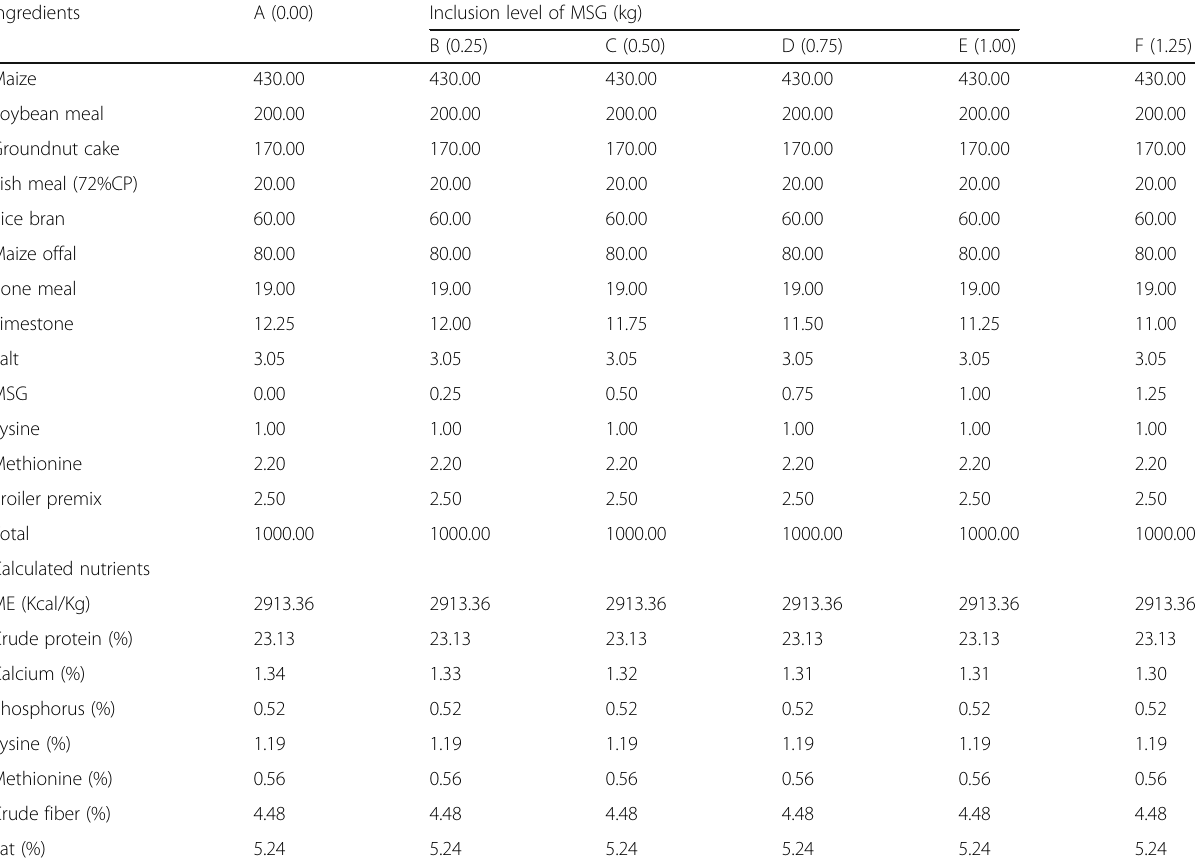
Table 1 Ingredient composition of the experimental starter diets (kg)